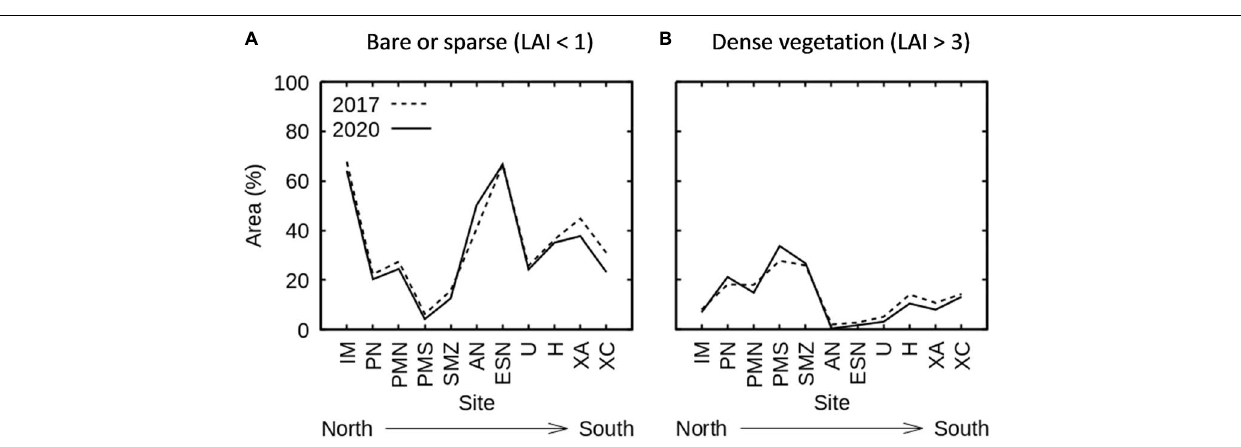
FIGURE 12 | Relative area of (A) bare substrate or sparse canopies (estimated LAI < 1) and (B) dense canopies (estimated LAI > 3) found at the eleven sites of interest, ordered from north to